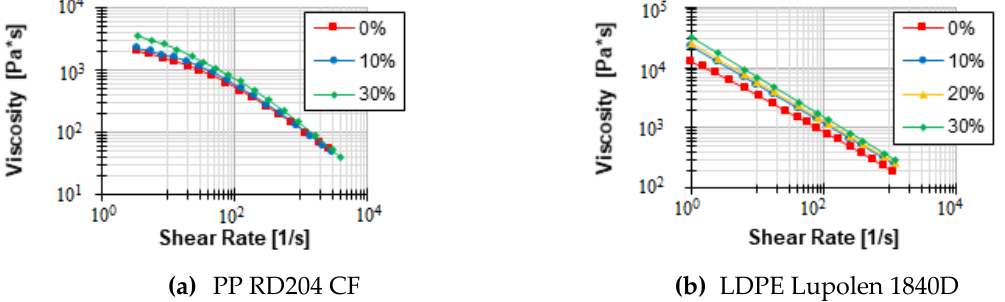
Figure 10. Viscosity above the shear rate for PP ( a ) and LDPE ( b ) and various solid contents.